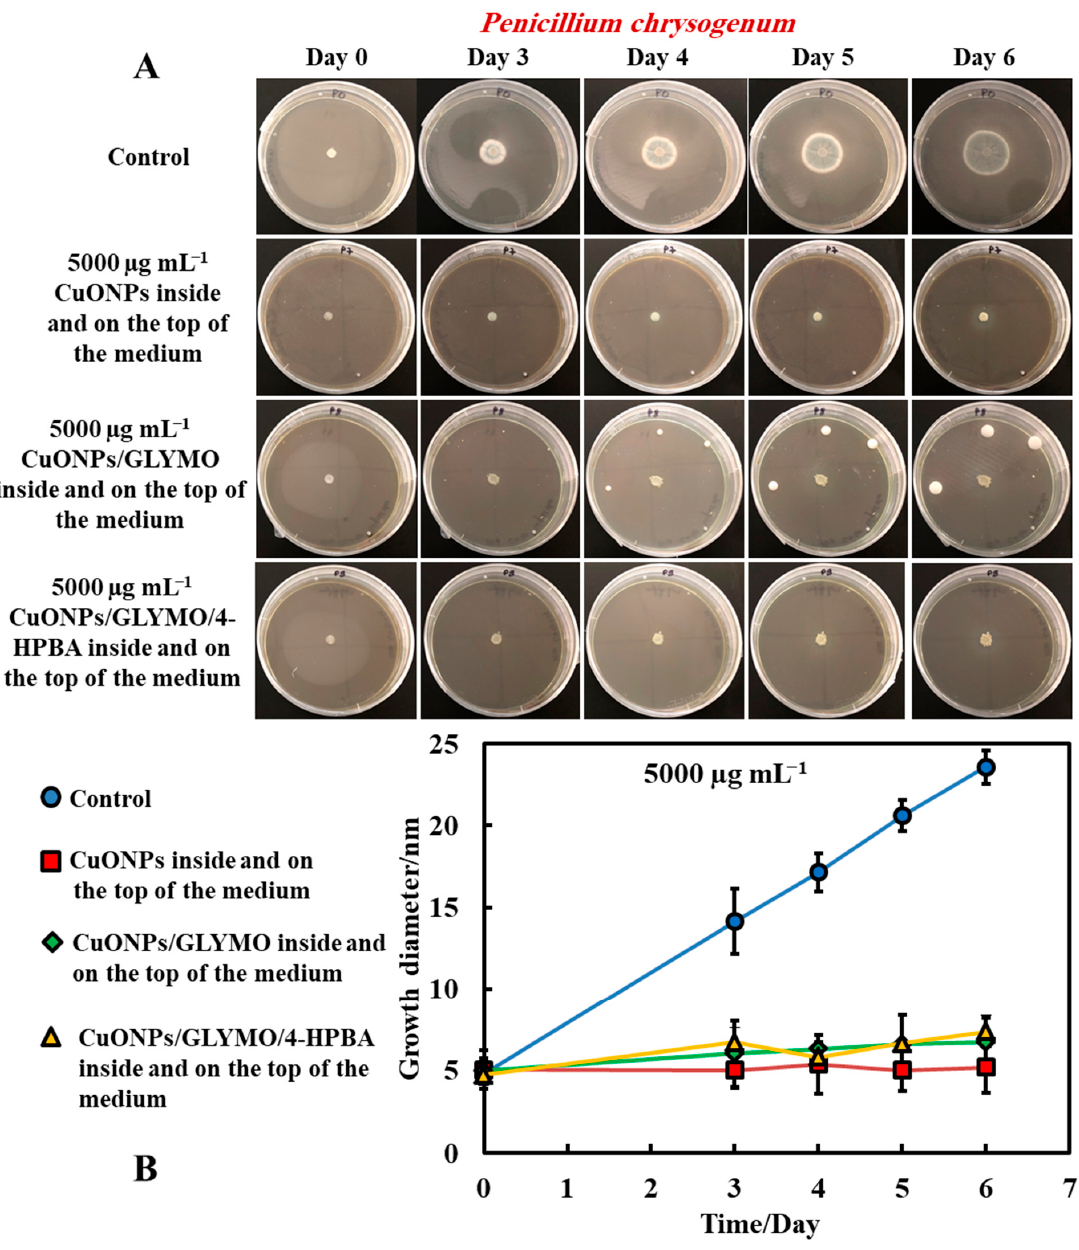
Figure 8. ( A ) Digital photographs of the PGA–gel plates containing P. chrysogenum in the center (impregnated paper disc) and with antimould agent at 5000 µg mL − 1 inside and on the top of the medium (Method 4), monitored for six days, in an incubator, at 25 °C. ( B ) Growth diameter of a circular spot of P. chrysogenum as a function of time for bare and surface-functionalized CuONPs. The solid lines are guides to the eye.